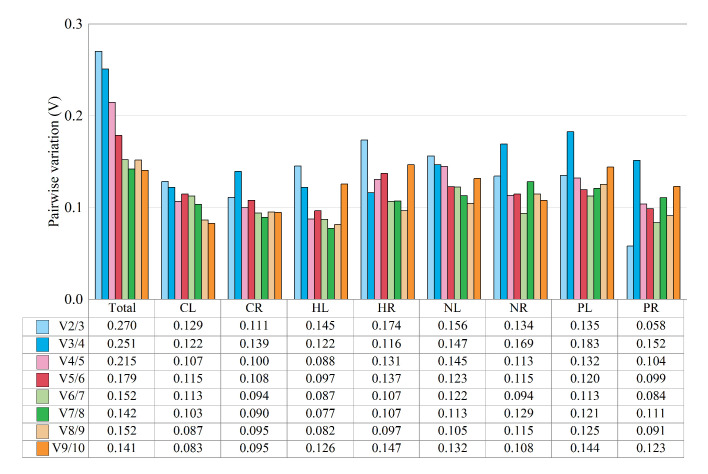
Pairwise variation (V) of candidate reference genes.The Vn/Vn+1 value is used to determine number of reference genes required for treatments; usually the value should be less than 0.15 for inclusion of a reference gene. CL and CR: Cold-treated leaves and roots, respectively; HL and HR: Heat-treated leaves and roots, respectively; NL and NR: Salt-treated leaves and roots, respectively; PL and PR: Drought-treated leaves and roots, respectively; Total: Pooled samples from all treatments.